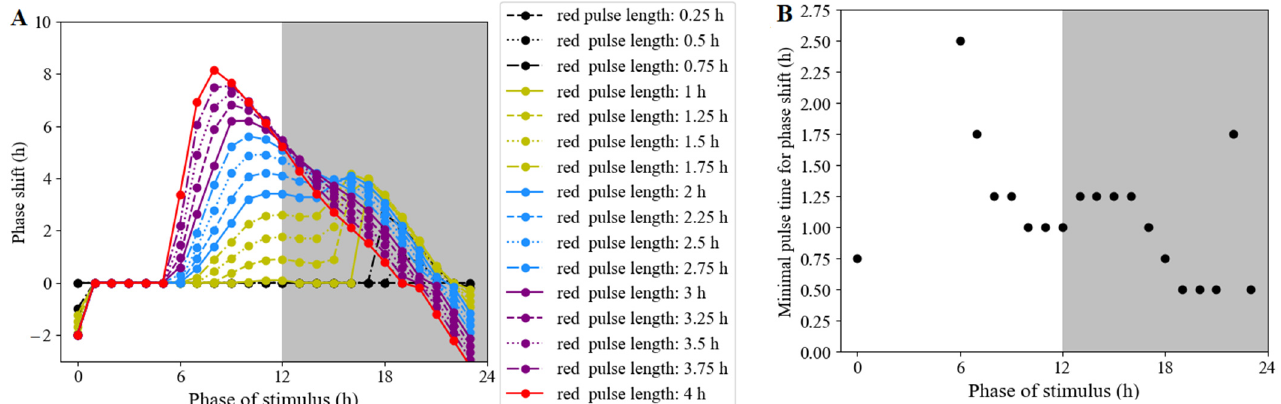
Figure 10. Phase-response curves measured under red-light pulses of various lengths. ( A ) The model was entrained under white-light/dark cycles (12 h light/12 h dark) for 5 days, then released to a red-light pulse at an indicated time. Each dot represents a pulse at an indicated time. ( B ) The minimum length of red-light pulse length required for producing an observable phase shift.